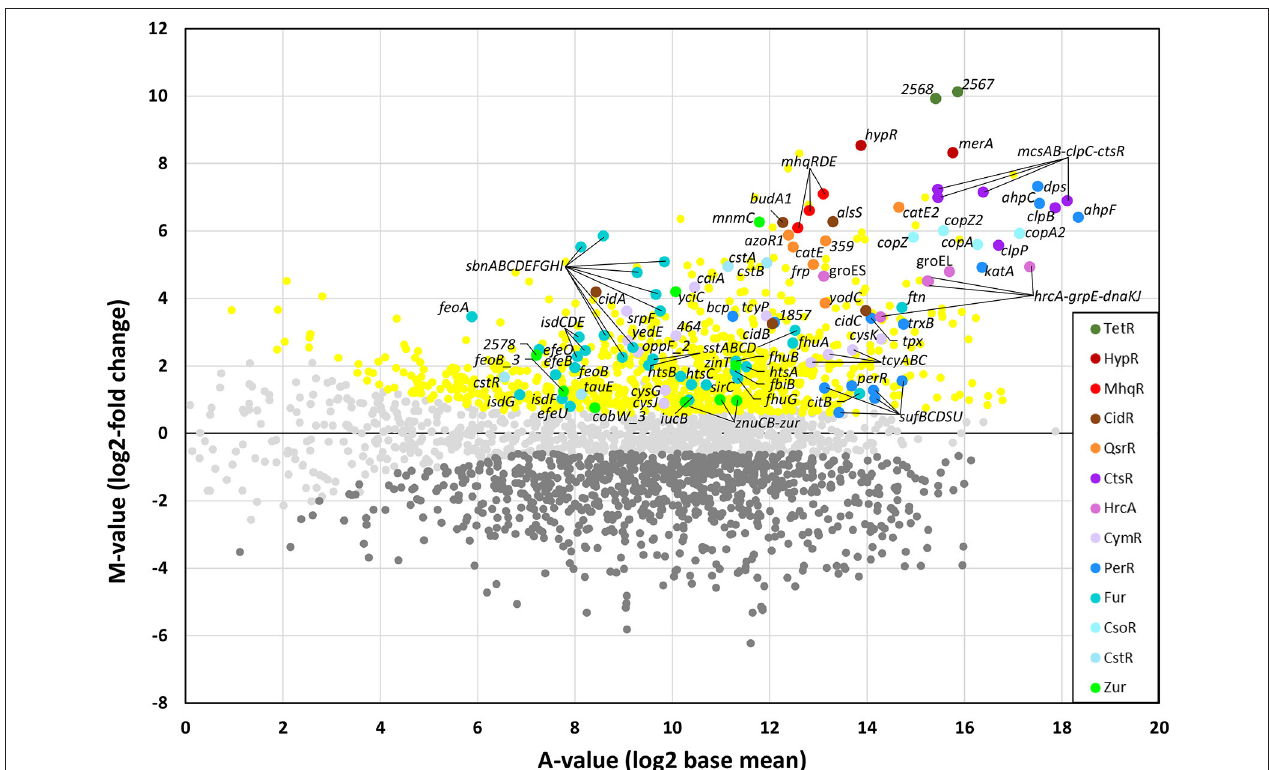
FIGURE 2 | RNA-seq transcriptomics of S. aureus USA300 after 30min of AGXX ® stress. For RNA-seq transcriptomics, S. aureus USA300 was grown in RPMI medium and treated with 4.5 µ g/ml AGXX ® for 30min. The gene expression profile under AGXX ® stress is shown as ratio/intensity scatter plot (M/A-plot) which is based on differential gene expression analysis using DeSeq2. Colored symbols indicate significantly induced (red, orange, brown, blue, cyan, violet, green, yellow) or repressed (dark gray) transcripts ( M ≥ 0.6 or ≤ -0.6; P ≤ 0.05). Light gray symbols denote transcripts with no fold-changes after AGXX ® stress ( P > 0.05). The PerR, TetR, HypR, QsrR, MhqR, CtsR, HrcA, CidR, CymR, Fur, CstR, CsoR, and Zur regulons are most strongly up-regulated under AGXX ® stress. The transcriptome analysis was performed from three biological replicates. The RNA-seq expression data of all genes after AGXX ® stress and their regulon classifications are listed in Tables S1, S2